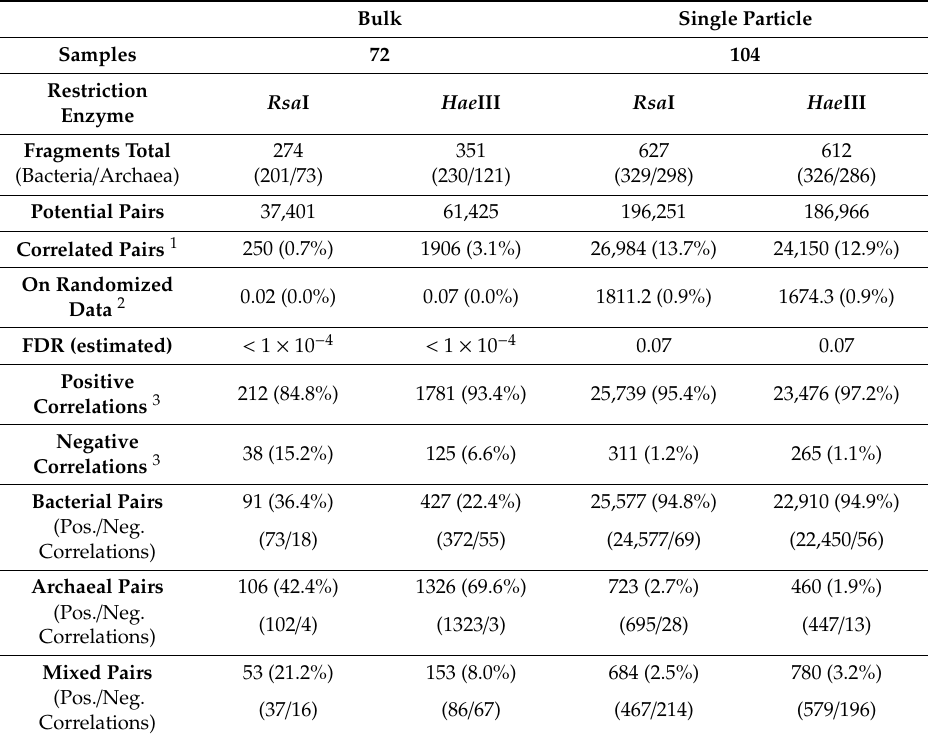
Table 1. Significantly correlated